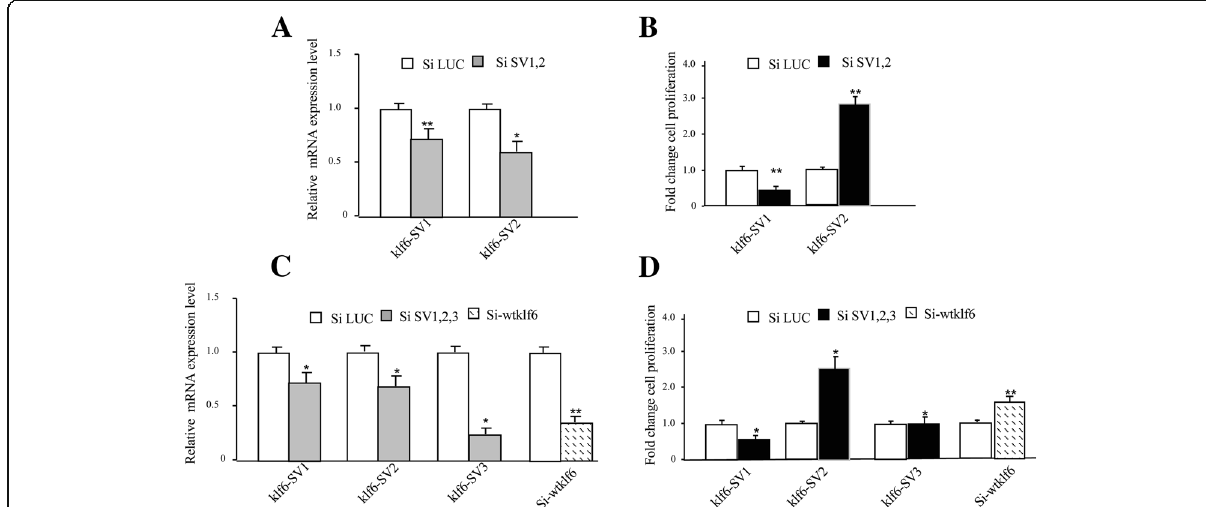
Fig. 3 Expression of Klf6-SV isoforms and cell proliferation assay in the target clones. a Expression assay of Klf6-SV1 and -SV2. The SE-del clone cells were transfected with pSuper-siSV1, 2 or control pSuper-siLuc. b Cell proliferation assay. [3H] thymidine incorporation was determined at 72 h. Each experiment was performed in triplicate, ** p < 0.01. c Expression assay of Klf6-SV isoforms : The SE-non-del clone cells were transfected with pSuper-siSV1,2,3 or control pSuper-siLuc. The SE-non-del clone cells were transfected with pSuper-si-wt Klf6 or control pSuper-siLuc. The results represent the mean of three amplifications, ** p < 0.01,* p < 0.05. d Cell proliferation assay. Each experiment was performed in triplicate, ** p < 0.01,* p < 0.05, # p >